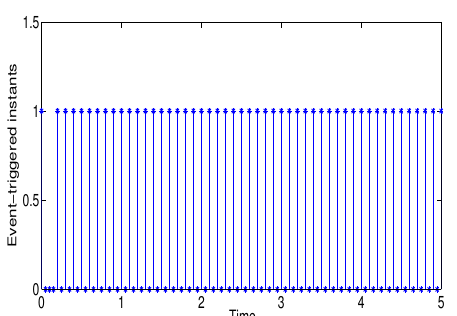
Figure 17. The cost function F ( t ) .